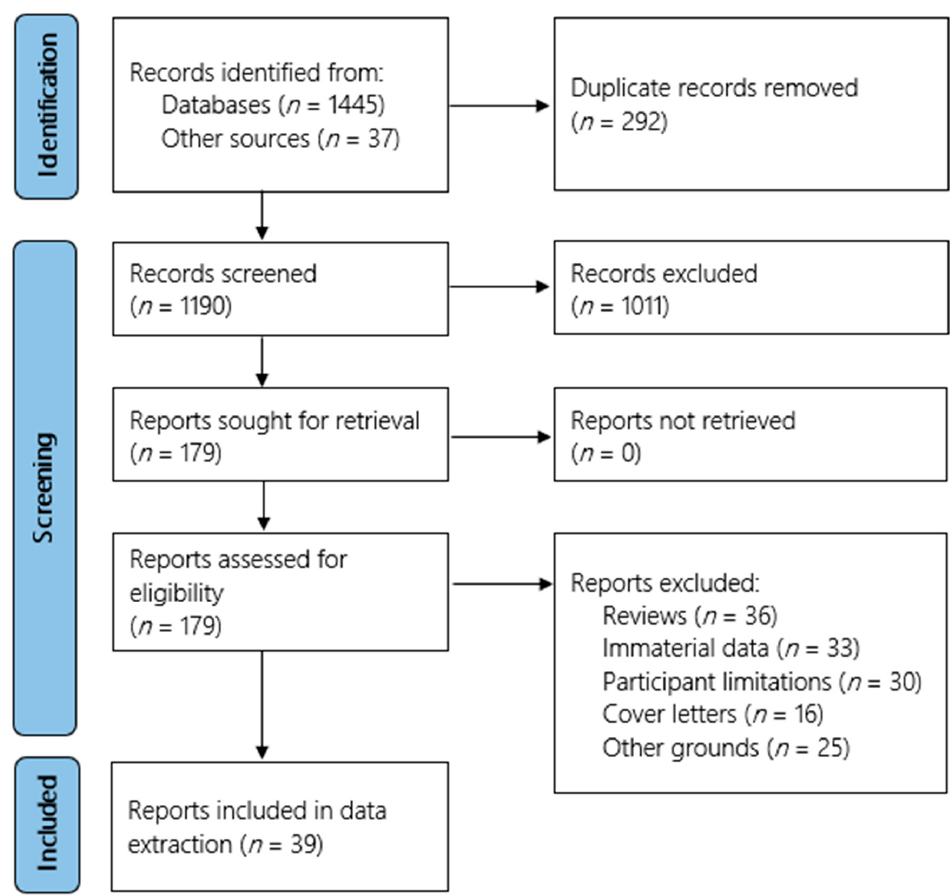
Figure 1. PRISMA flow diagram.